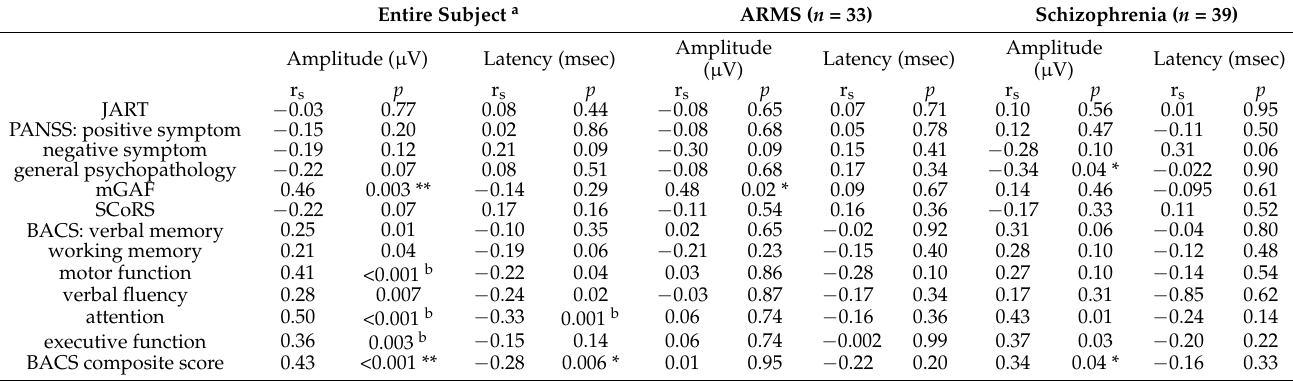
Figure 2. P300 waveforms at the T3, T4, Fz, Cz, and Pz leads. Grand average waveforms for subjects with ARMS who later developed psychosis (ARMS-P; red lines) and those who did not (ARMS non-converters) (ARMS-NP; brown lines). For comparison, waveforms of healthy controls (black lines) and those of patients with schizophrenia (gray lines) are also shown. Table 3. Correlations between P300 parameters and clinical